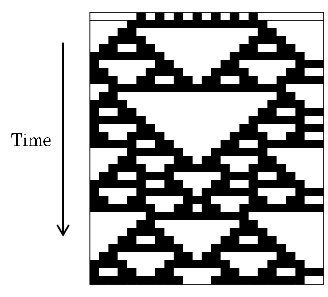
Figure 2. One of the patterns produced by Wolfram’s 1D cellular automaton (CA) model. Rule 126: white cell indicates the 0 state, while the black cell indicates the 1 state. The upper line corresponds to the initial condition. Applying this rule, the time series pattern produces a range of triangular shapes, in this case resembling a certain type of seashell.